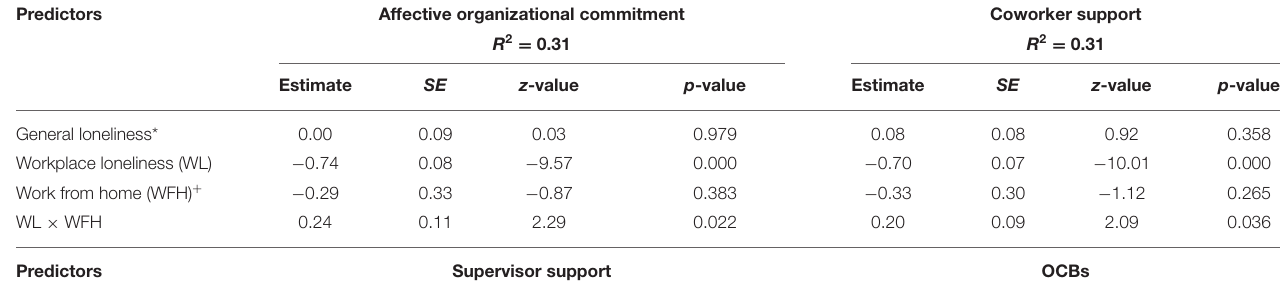
TABLE 3 | Path analysis regressing affective organizational commitment, coworker support, supervisor support, OCBs, and perceived job performance on workplace loneliness, working from home, and their interaction ( N = 362).